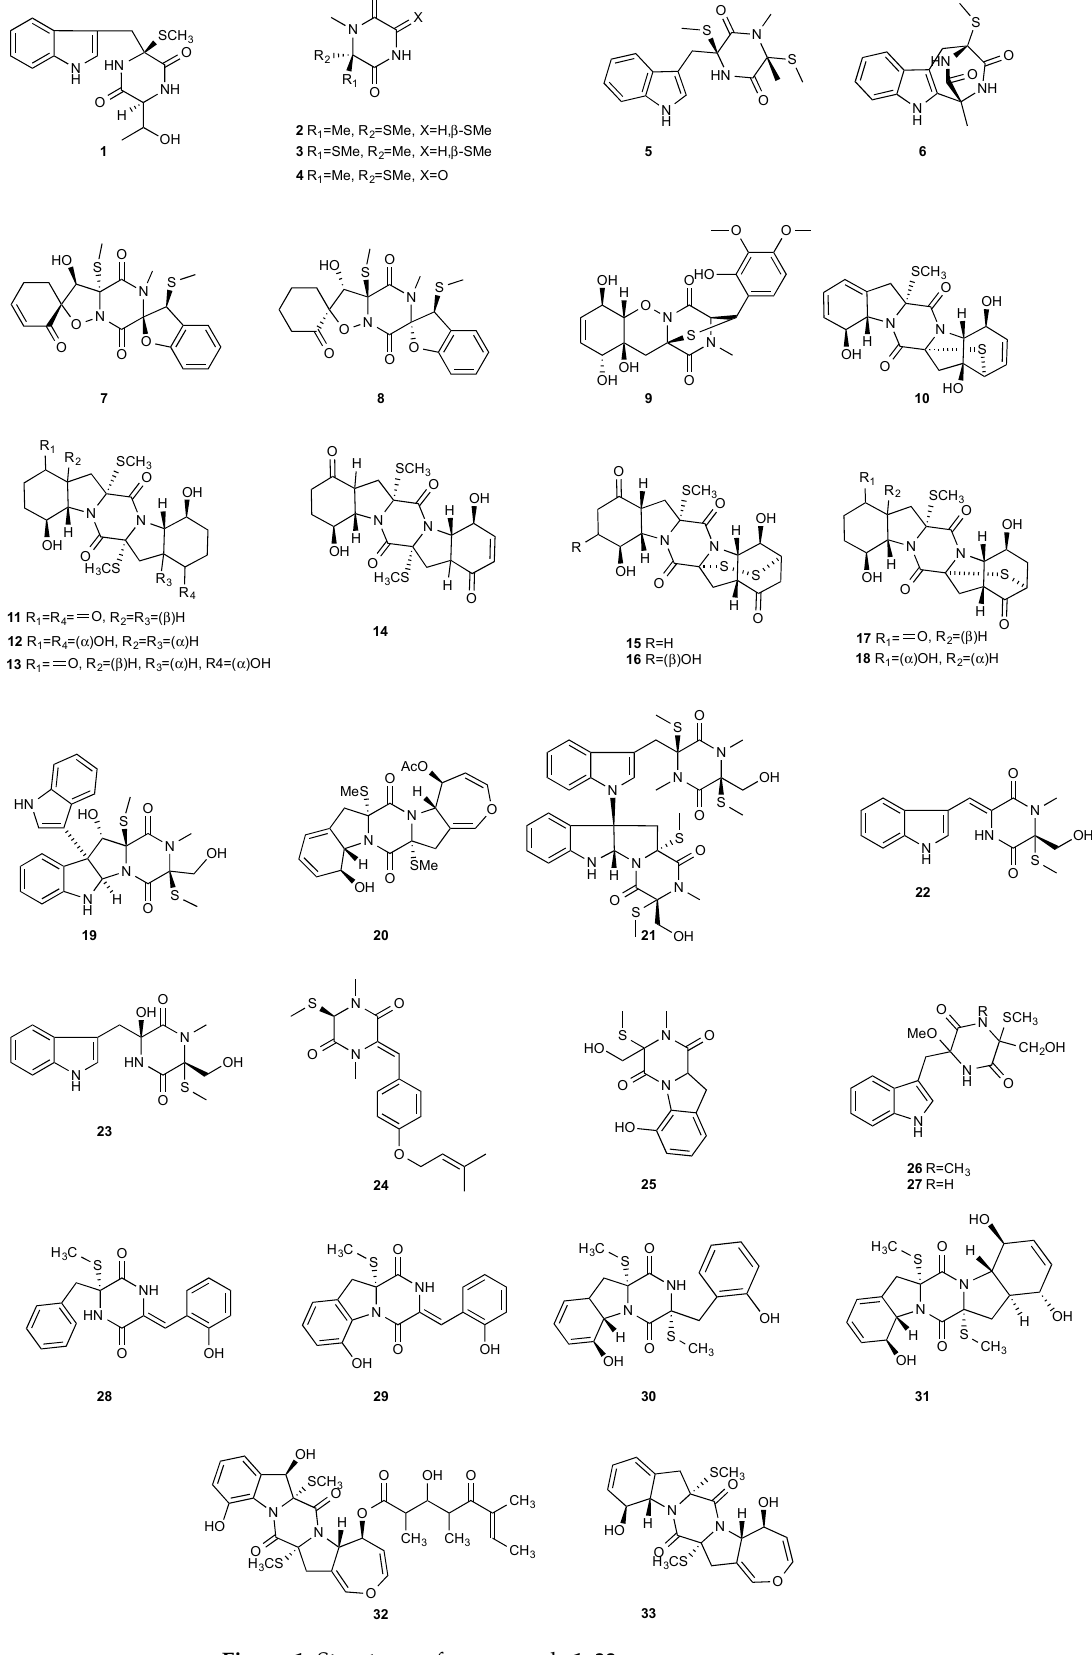
Figure 1. Structures of compounds 1 – 33 .